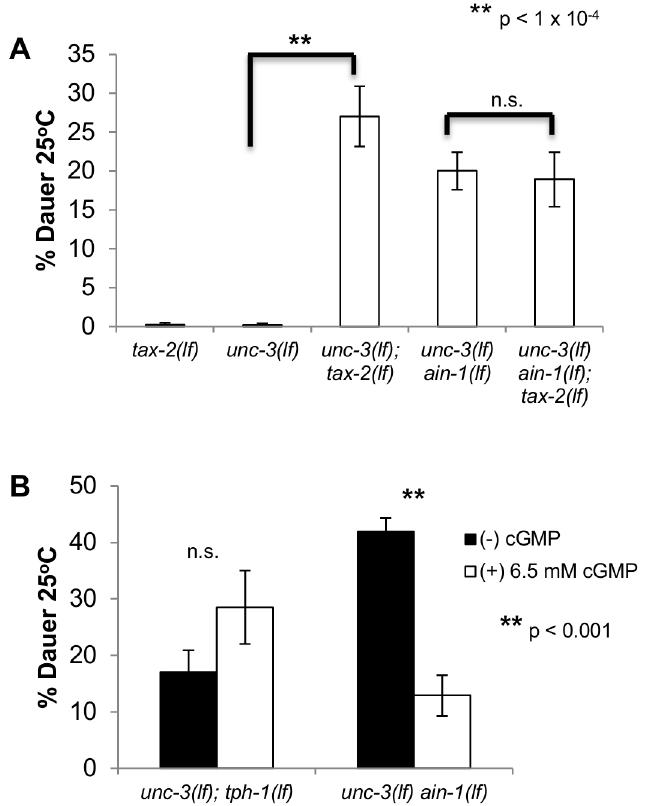
Figure 3. miRNAs may modulate cGMP signaling. A and B. Bar graphs representing the percent of dauer progeny of indicated genotypes and conditions. A. All mutants were assayed in the same experiment. Alleles used are unc-3(e151 lf), ain-1(ku322), and tax-2(p691 lf) B. The original unc- 3(e151 lf) ain-1(ku322 lf) mutant was used in this experiment. This assay was scored blindly between ( 2 )/( + ) cGMP plates. Each trial consisted of four independent plates, and the median percent dauer between scored plates was taken for each trial. Error bars represent S.E.M. from at least three biological replicates. A student’s t-test was done to determine statistical significance for all experiments.